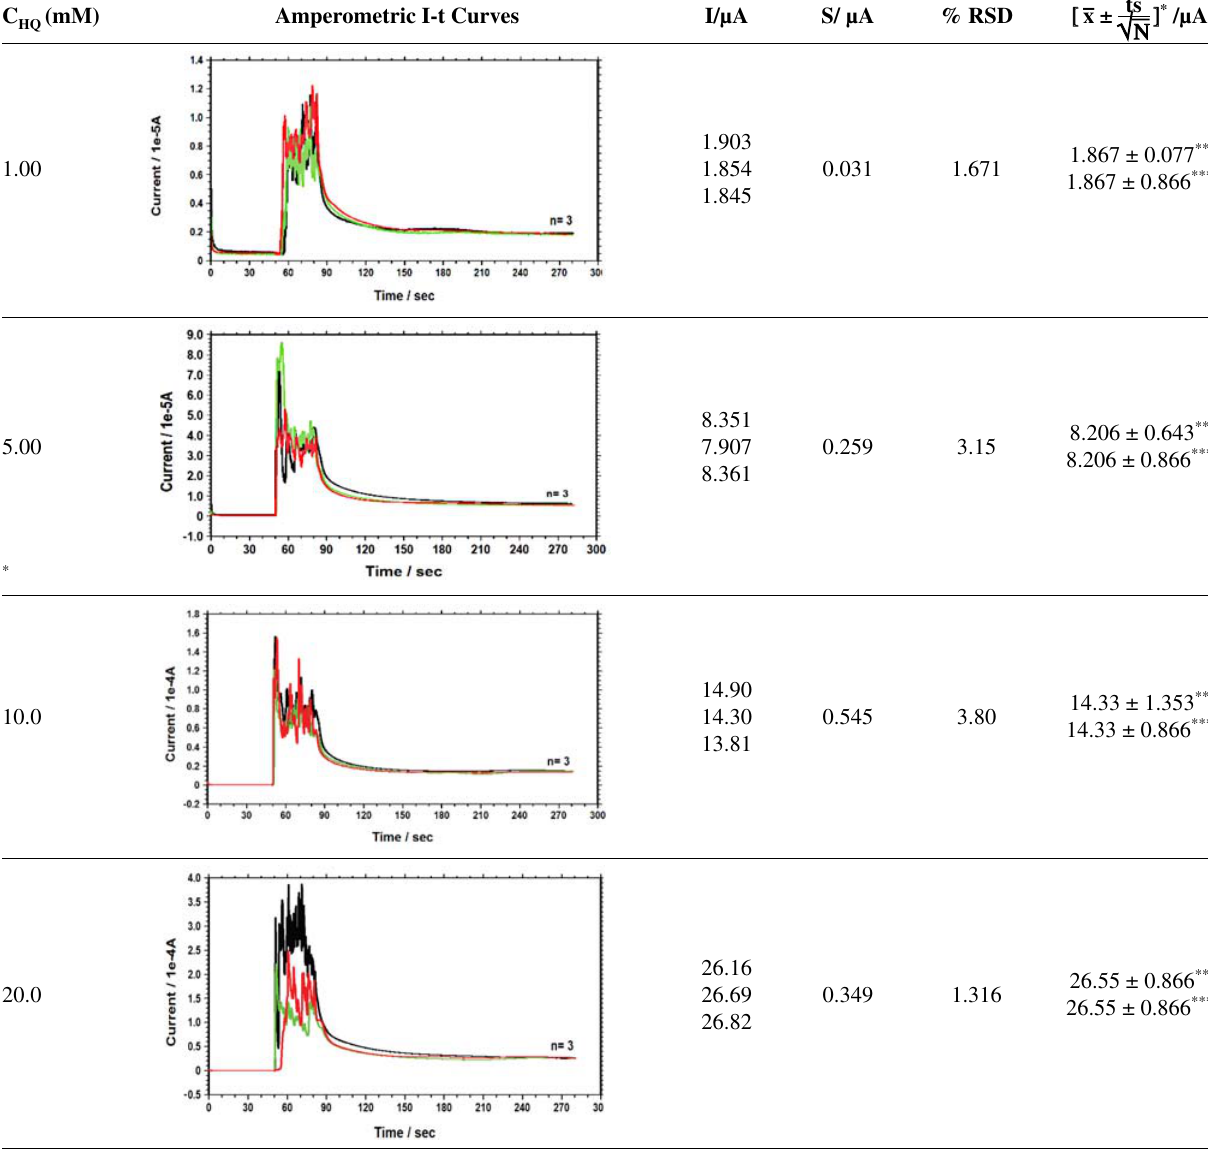
Table 2. Assessment of reliability of the results obtained from repeatability experiments for the determination of HQ over PANI-P3MT-PDAB modified electrode C HQ